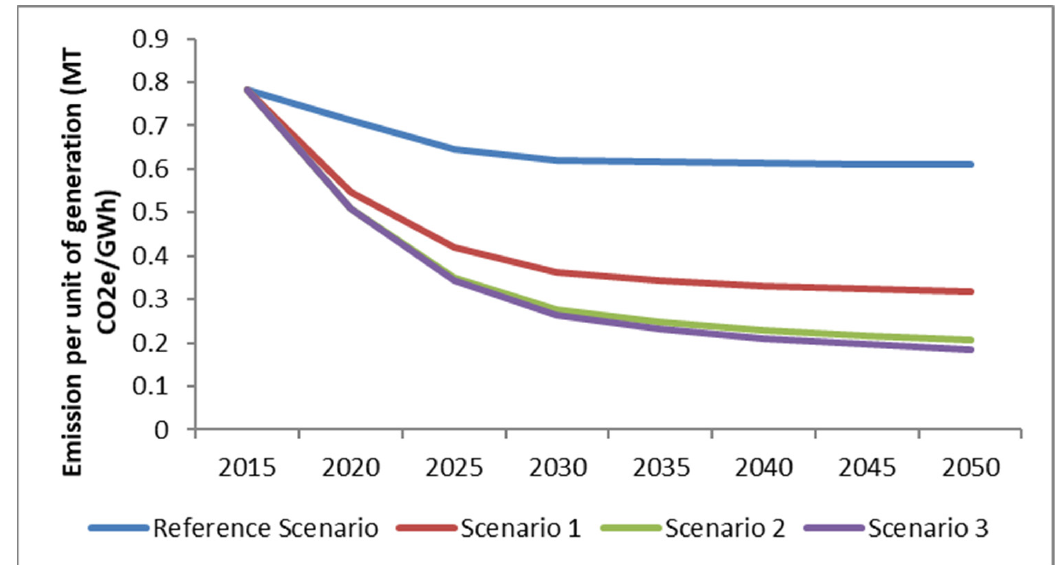
Figure 3. Emissions per unit of generation under different scenarios.